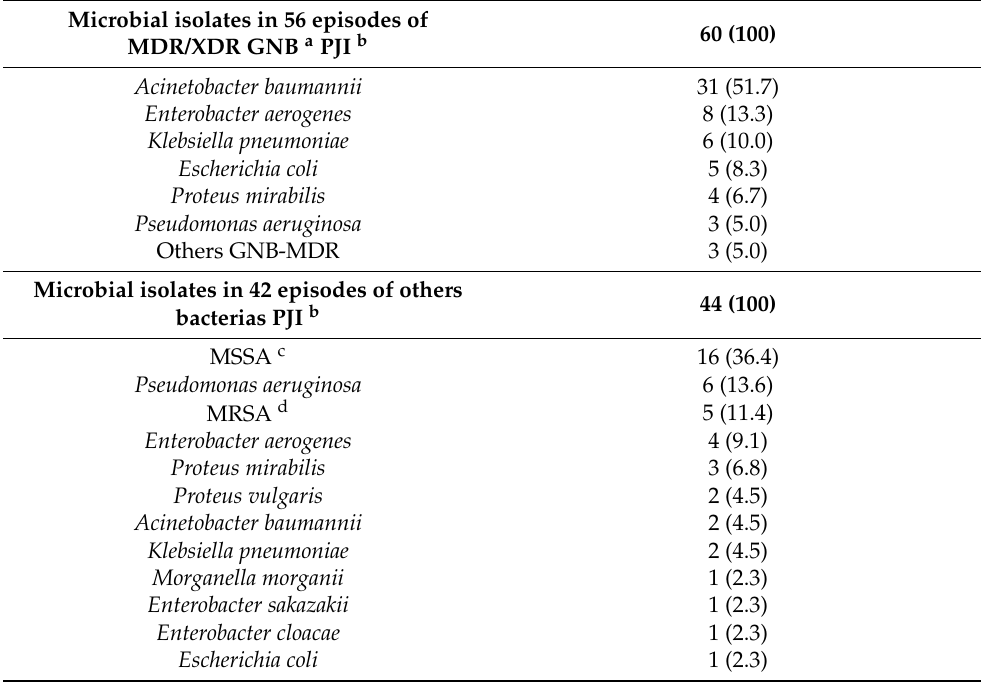
Table 2. Description of 104 microorganisms isolated from bone and soft tissue cultures of patients with PJI described in the